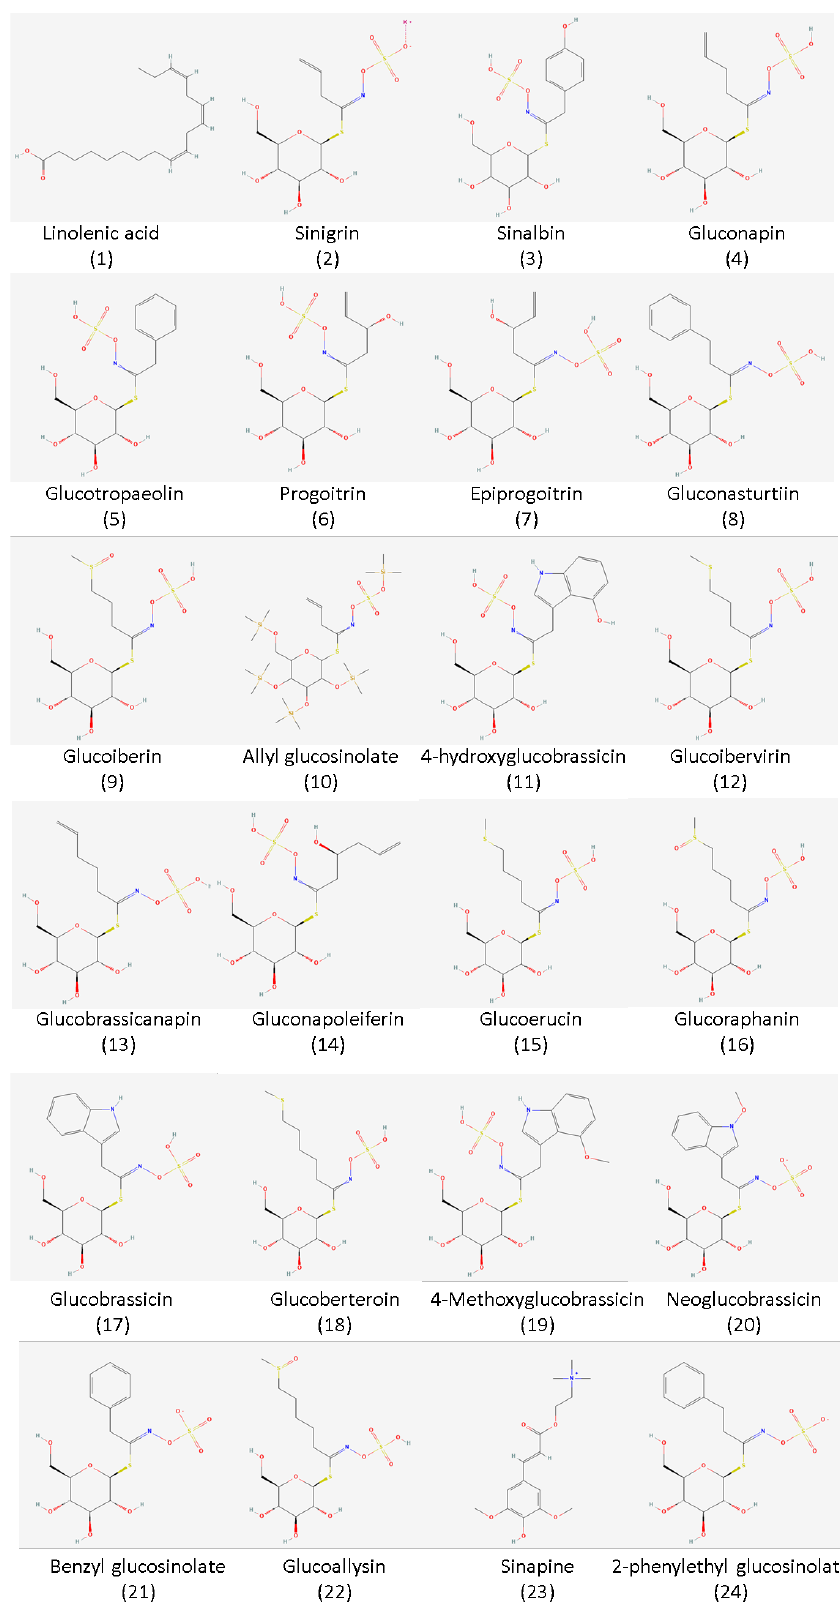
Figure 2. Chemical structure of the most common GSLs isolated from the seeds of mustard plants. The chemical structures were obtained from PubChem (https://pubchem.ncbi.nlm.nih.gov/; accessed on 20 August 2022).